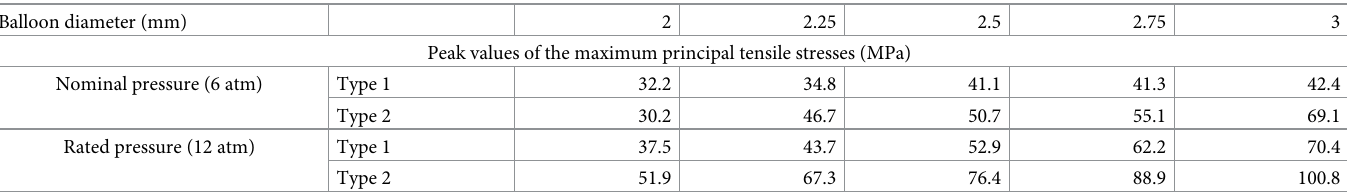
Table 2. Peak values of the maximum principal tensile stresses in the calcification models.